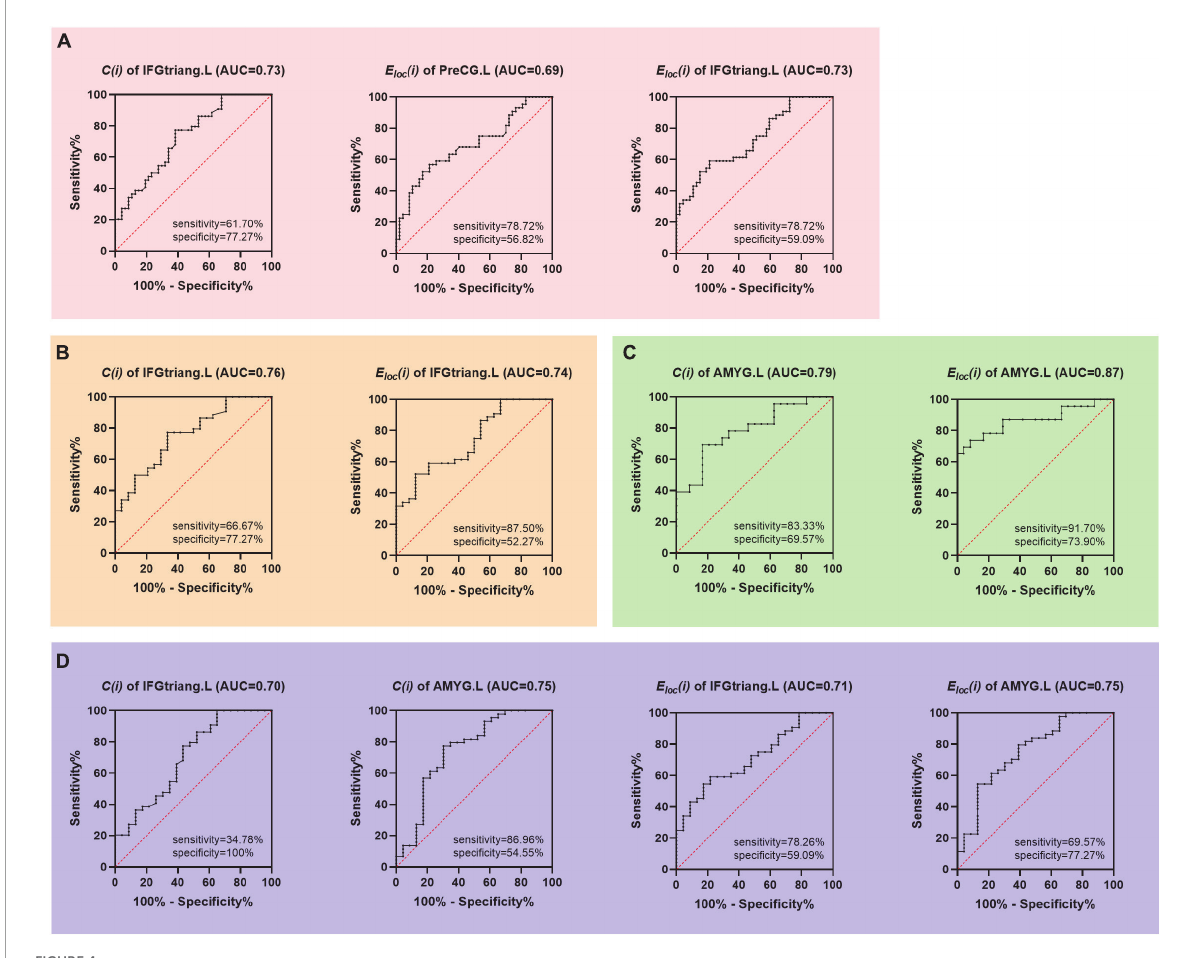
FIGURE4 Receiver operator characteristic (ROC) curves based on the abnormal nodal segregative parameters. (A) Discrimination PE from HC; (B) discrimination primary PE from HC; (C) discrimination primary PE from acquired PE; (D) discrimination acquired PE from HC. PE, premature ejaculation; HC, health controls. PreCG.L, left precental gyrus; IFGtriang.L, left inferior frontal gyrus (triangular part); AMYG.L, left amygdala. C ( i ), the clustering coefficient of node i ; E loc ( i ), the local efficiency of node i . AUC, area under the